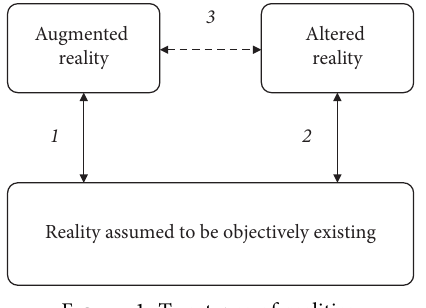
Figure 1: Two types of